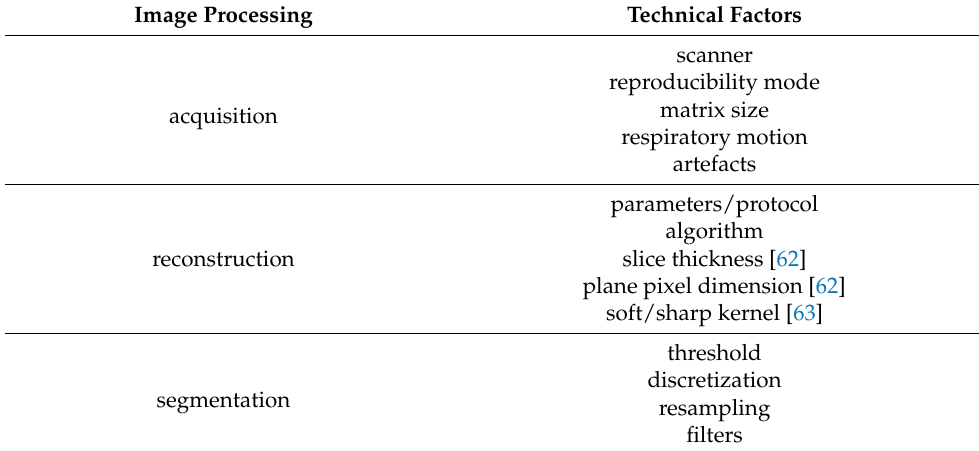
Table 2. Steps of radiomic workflow with influencing technical